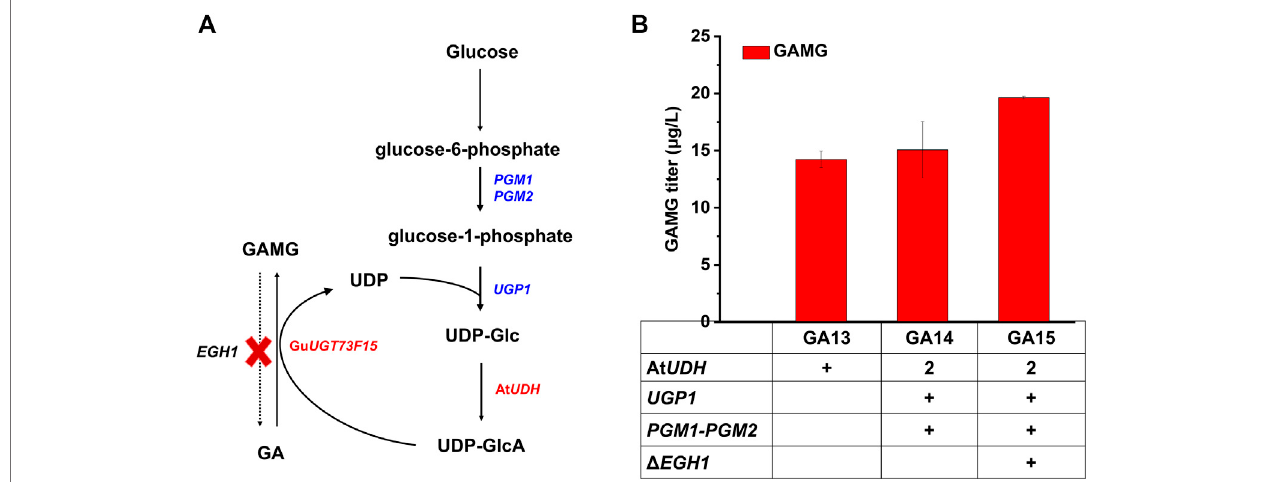
FIGURE3| OptimizationoftheUDP-GlcAmodule(moduleII)forimprovingGAMGproduction,includingthepreventionofGAMGdegradationandenhancementof UDP-GlcA supply. (A) UDP-GlcA biosynthetic pathway and its involvement in GA glycosylation. PGM1 , PGM2 , UGP1, and At UDH were overexpressed to enhance UDP-GlcA supply. EGH1 was deleted to prevent GAMG degradation. (B) Comparison of GA and GAMG production in engineered S. cerevisiae strains. PGM1: phosphoglucomutase 1; PGM2: phosphoglucomutase 2; UGP1: UDP-glucose pyrophosphorylase; AtUDH: UDP-glucose dehydrogenase from A. thaliana ; GuUGT73F15: UDP-glucuronyltransferase. Error bars represented SD of biological